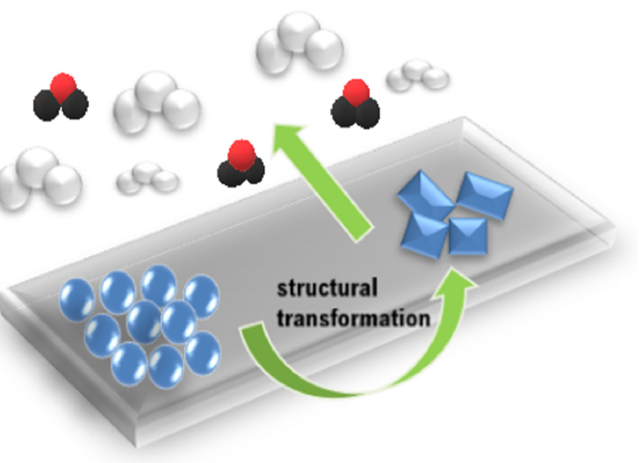
Figure 7. Schematic diagram of the transformation of Cu NP ensembles. (Adapted from [94] with PNAS permission). from Ref. [94]. Copyright